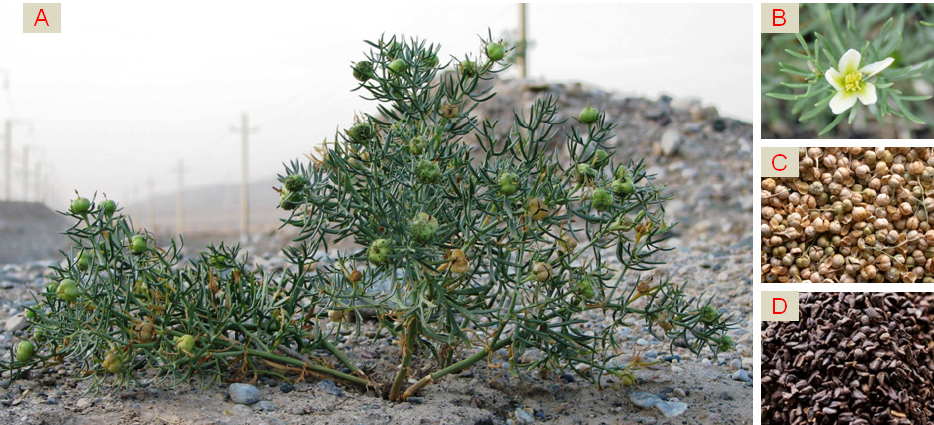
Figure 1. P. harmala ( A ) plant; ( B ) flower; ( C ) ripe fruits; ( D )